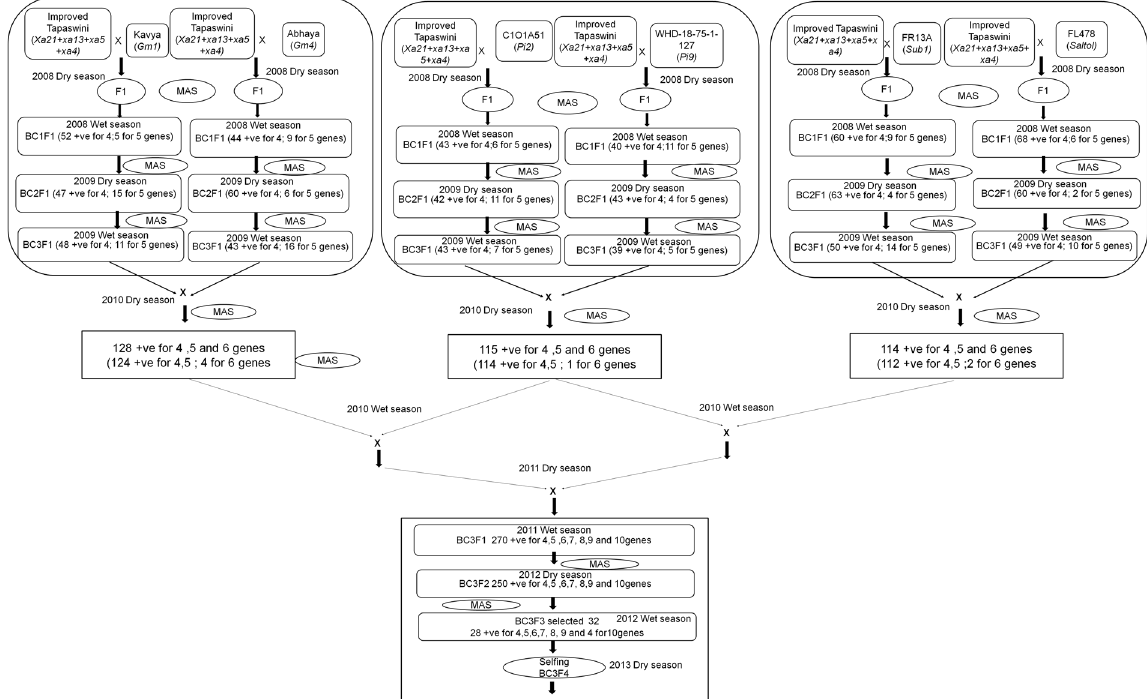
Figure 2. Flow diagram depicting the different steps of development of gene pyramids of Improved